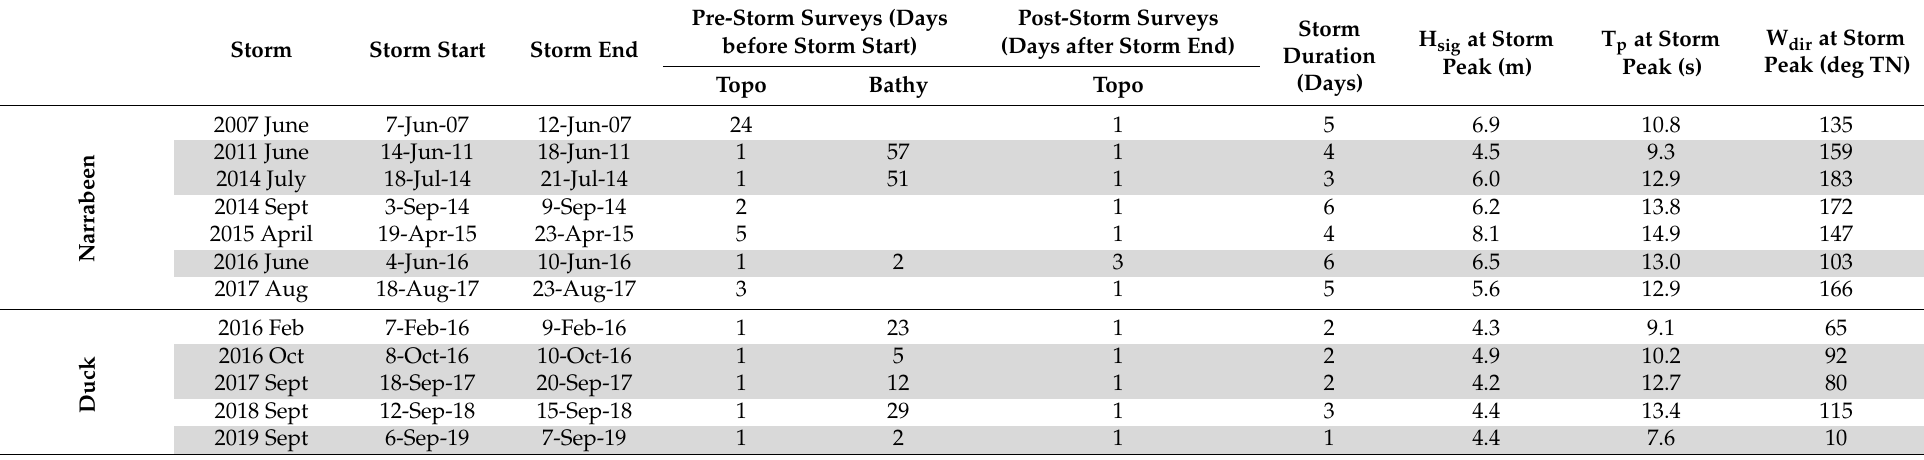
Table 1. Summary of all storm events modelled in this study and the surveyed datasets available for these events. Pre-Storm Surveyed bathymetry is available only for a limited number of storms at Narrabeen. Storm events where these data are not available have been left blank. The three storms used for model calibration at each site are highlighted in